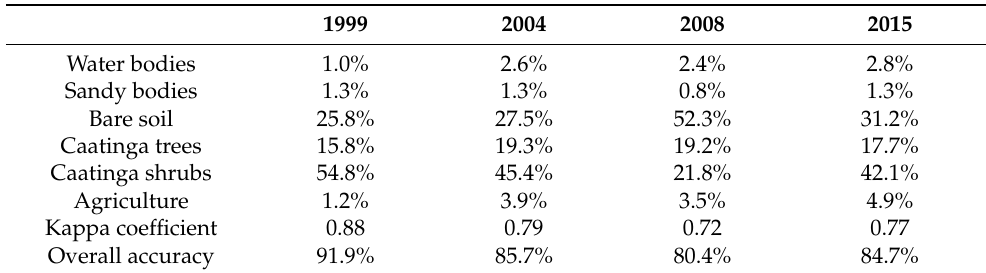
Table 4. Area percentage of each class, Kappa coefficient, and overall accuracy by